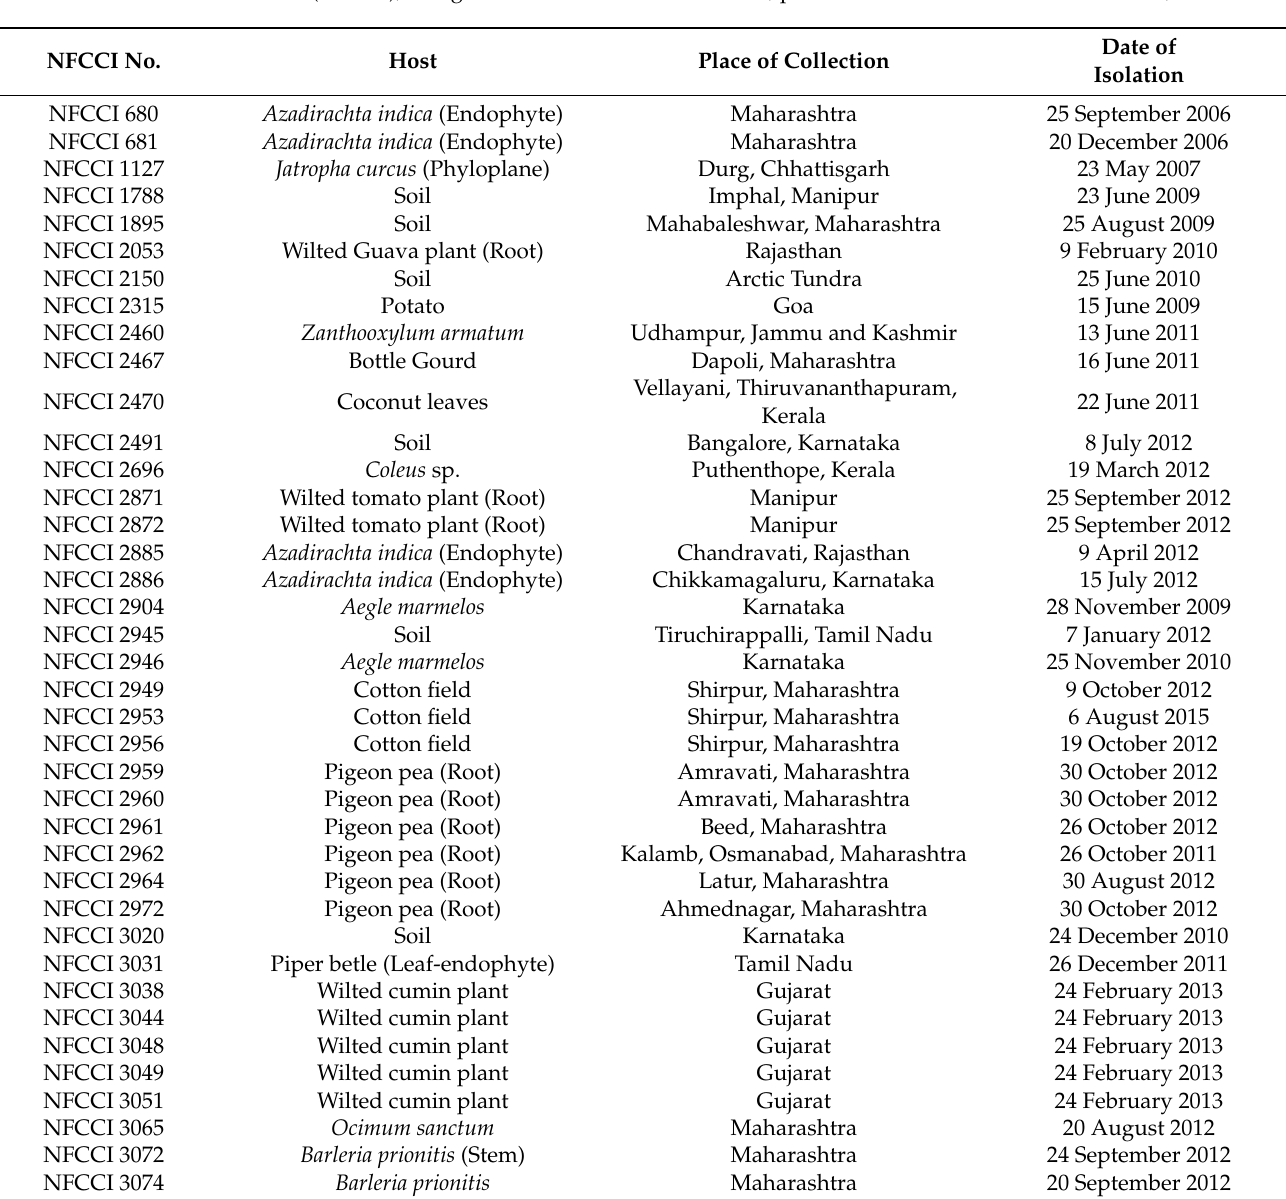
Table 1. Sixty-four Fusarium isolates procured from the National Fungal Culture Collection of India (NFCCI), along with other details such as host, place of collection and date of isolation, are listed. NFCCI No. Place of